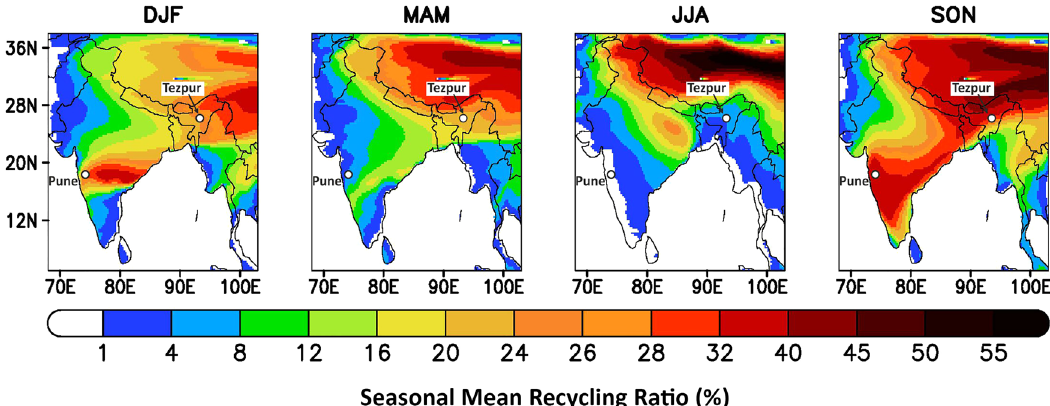
Fig. 6 Recycling ratio. The seasonal mean recycling ratio (recycled to total rainfall in %) estimated using ERA5 data (2014 – 2018) by employing the recycling model of Eltahir and Bras 43